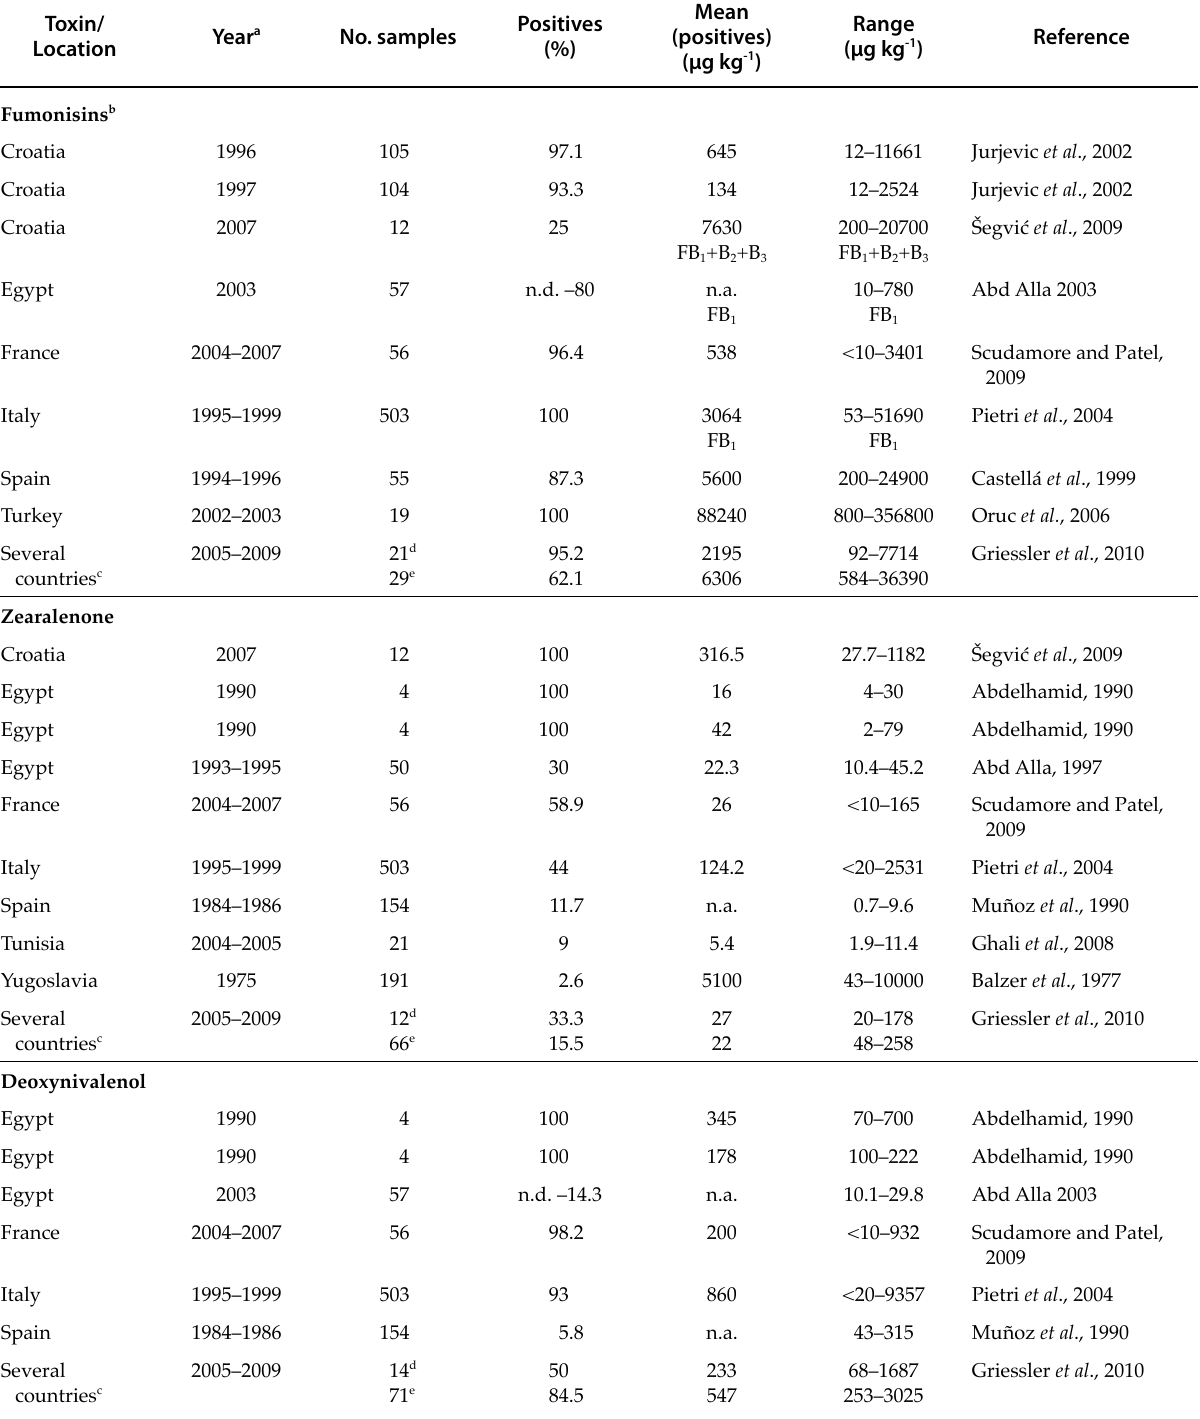
Table 6. Occurrence of Fusarium toxins in postharvest maize and maize-based products from Mediterranean countries. Toxin/